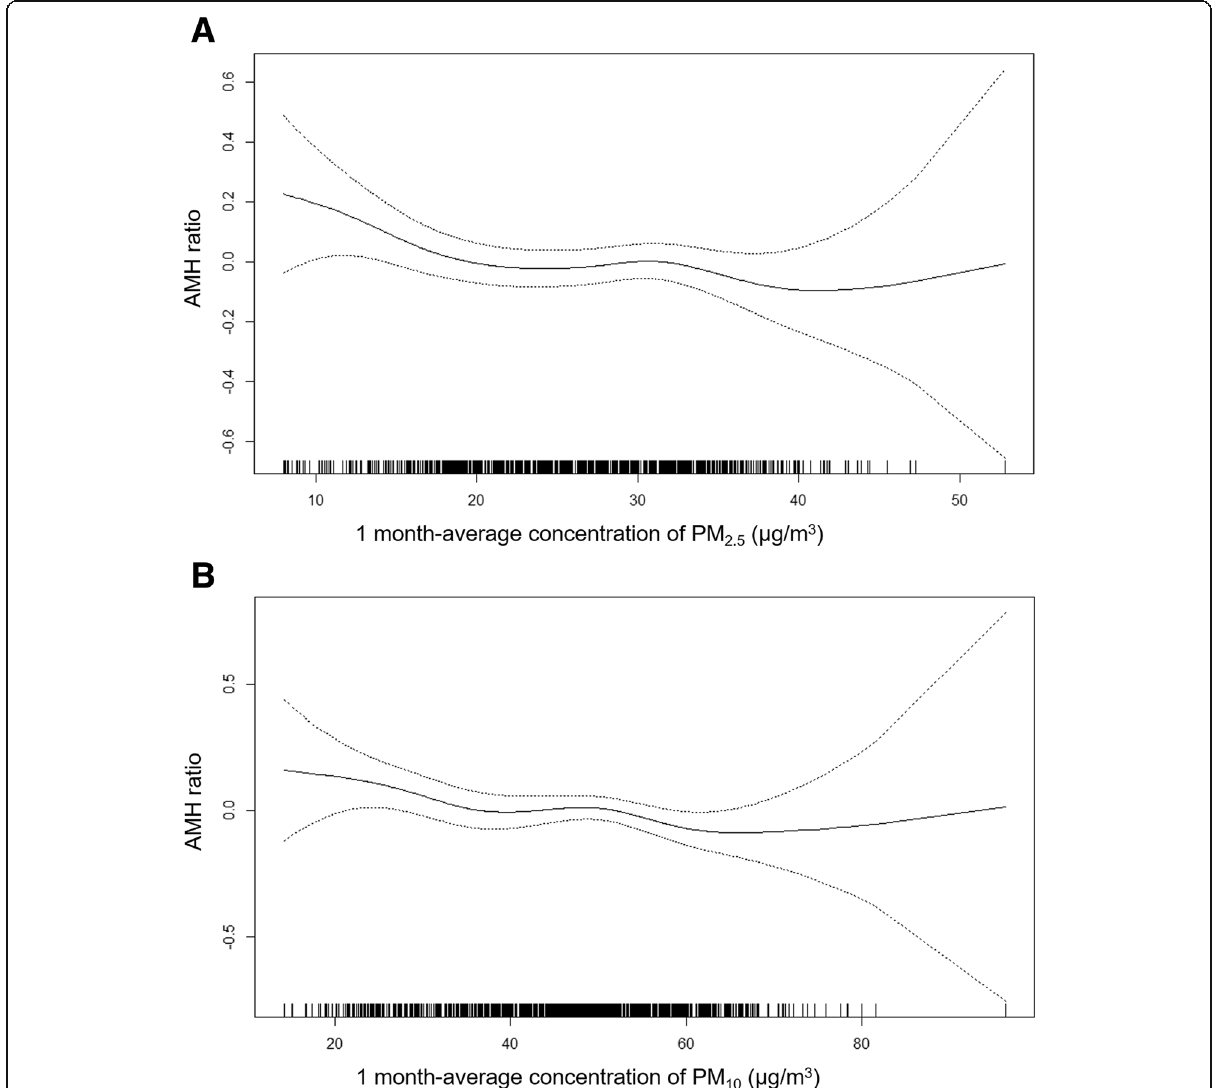
Fig. 1 Association between ovarian reserve and air pollutant concentrations. a A 1-month average PM 10 and the AMH ratio in total population and b a 1-month average PM 2.5 and the AMH ratio in Seoul residents. Generalized additive models with non-parametric smoothing splines were used. Interrupted lines indicate 95% confidence intervals of